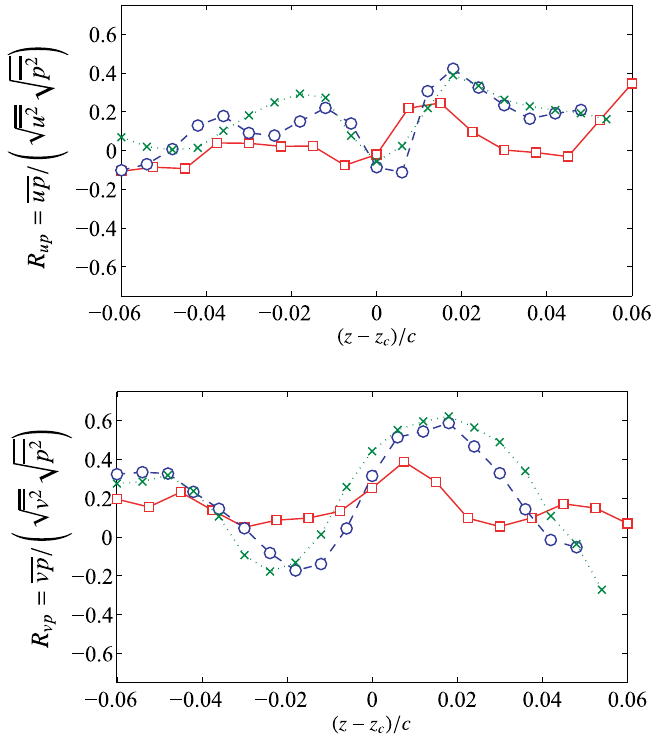
Fig. 9 Profiles of the correlation coe ffi cient of velocity and pressure thorough the vortex center: (a) up ; (b) v p (same symbols notation as Fig. 7).